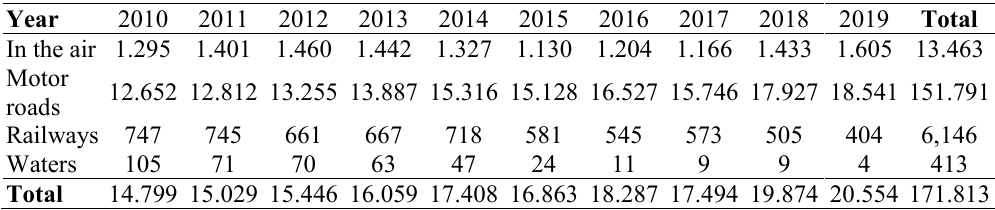
Table 1. The Number of Cases with the Presence of Dangerous Substances in the USA in the period of 2010–2019 (United States of America Department of Transportation,